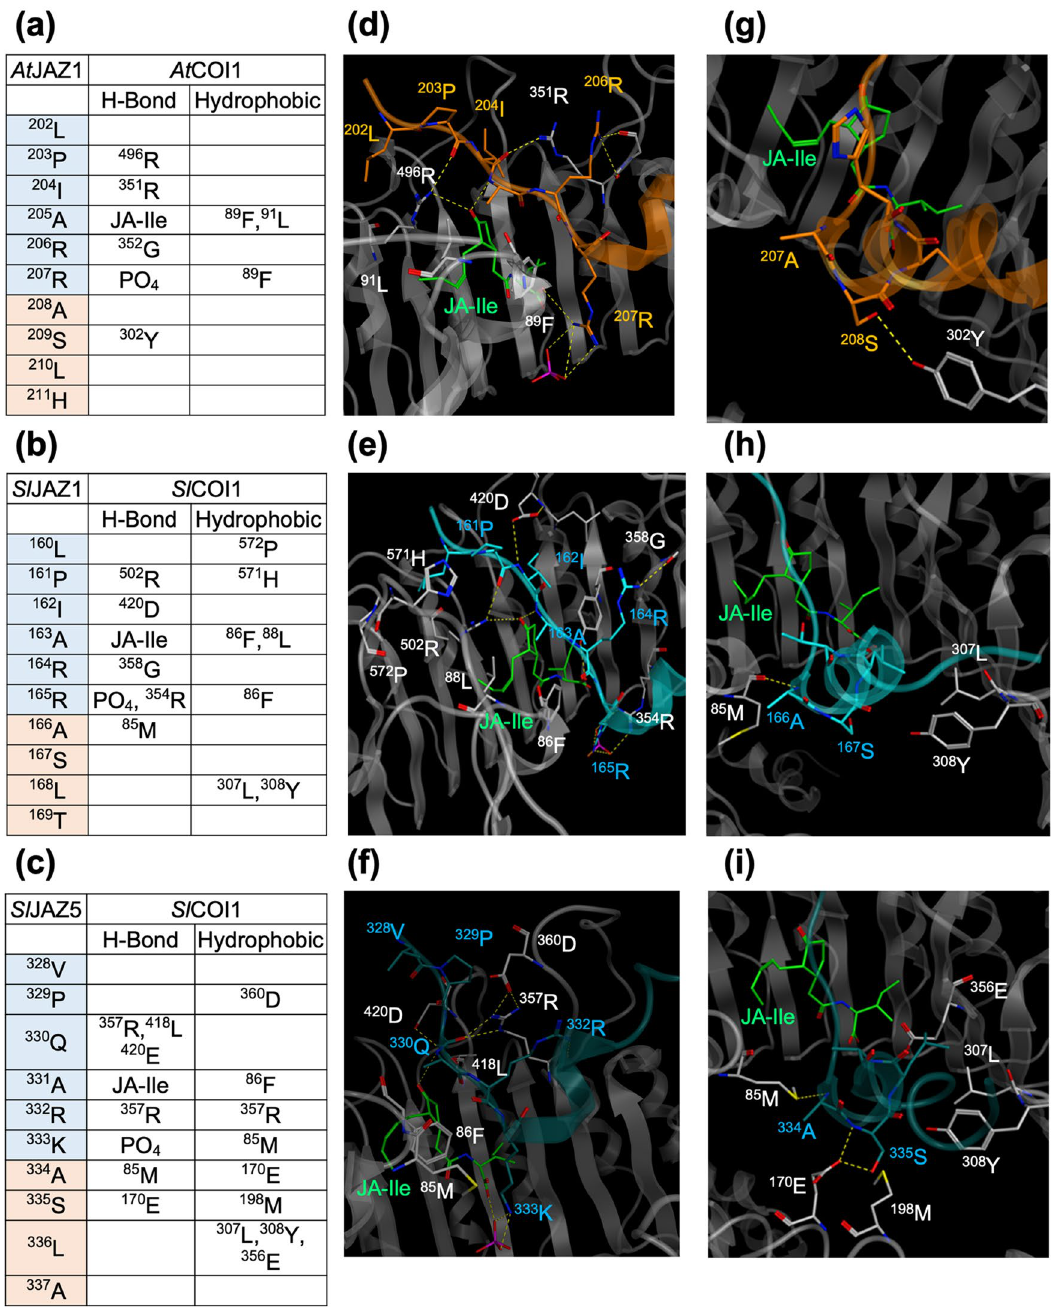
Figure 6. In silico analyses of At COI1-JA-Ile- At JAZ1 (PDB ID: 3OGL, a , d , g ), Sl COI1-JA-Ile- Sl JAZ1 ( b , e , h ), and Sl COI1-JA-Ile- Sl JAZ5 ( c , f , i ) to show the binding mode of the extended degron. ( a – c ) The amino acid residues forming hydrogen bonds (H-bond) or hydrophobic interaction (Hydrophobic) between COI1 and JAZ observed in the crystal structure of At COI1-JA-Ile- At JAZ1 (3OGL, a ), MD simulation of Sl COI1-JA-Ile- Sl JAZ1 ( b ) and MD simulation of Sl COI1-JA-Ile- Sl JAZ5 ( c ). ( d ) The reported structure around the degron sequence of At JAZ1 in the complex of At COI1-JA-Ile- At JAZ1. ( e , f ) The obtained MD structure around the degron sequence of Sl JAZ in the complex of Sl COI1-JA-Ile- Sl JAZ1 ( e ) or Sl COI1-JA-Ile- Sl JAZ5 ( f ). ( g ) The reported structure around the DOD sequence of At JAZ1 in the complex of At COI1-JA-Ile- At JAZ1. ( h , i ) The obtained MD structure around the DOD sequence of Sl JAZ in the complex of Sl COI1-JA-Ile- Sl JAZ1 ( h ) or Sl COI1-JA- Ile- Sl JAZ5 ( i ). Hydrogen bonds are shown as yellow dotted lines. The images of the 3D structures were created by MOE